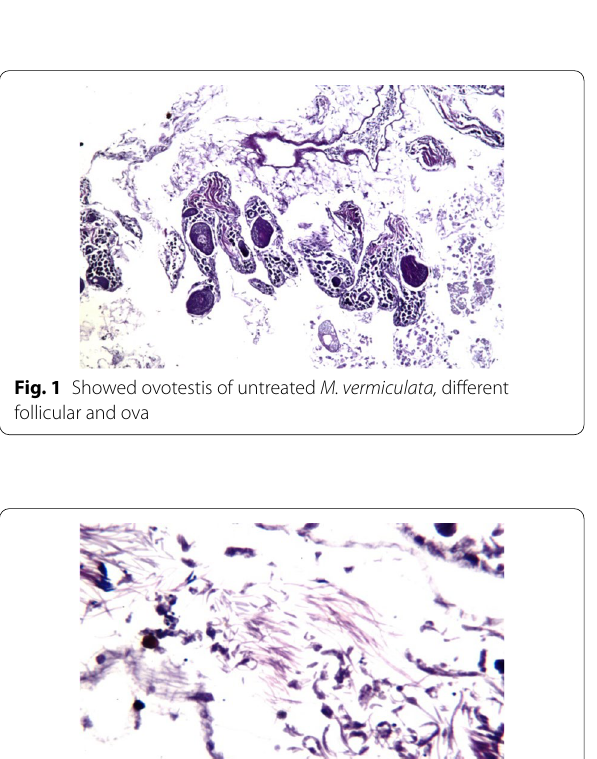
Hatchability % = No. of hatching in one mass No.ofegginonemass × 100 a Significant, b non significant at p < 0.05